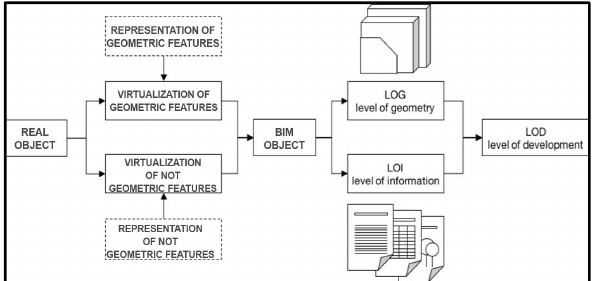
Figure 1. UNI 11337:2017. Standard on the “Digital management of IT processes in construction”. Part 4: “Evolution and data development of models and objects”